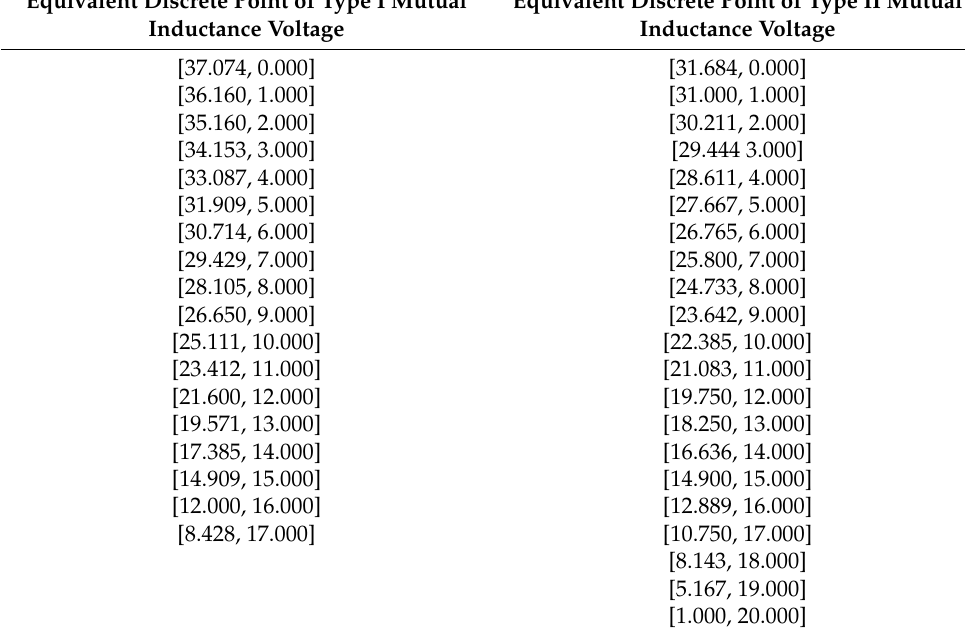
Table 1. Equivalent discrete point of double mutual inductance voltages when the relative displace- ment is [15, 15] at 20 ◦ inter-axis angle (unit: